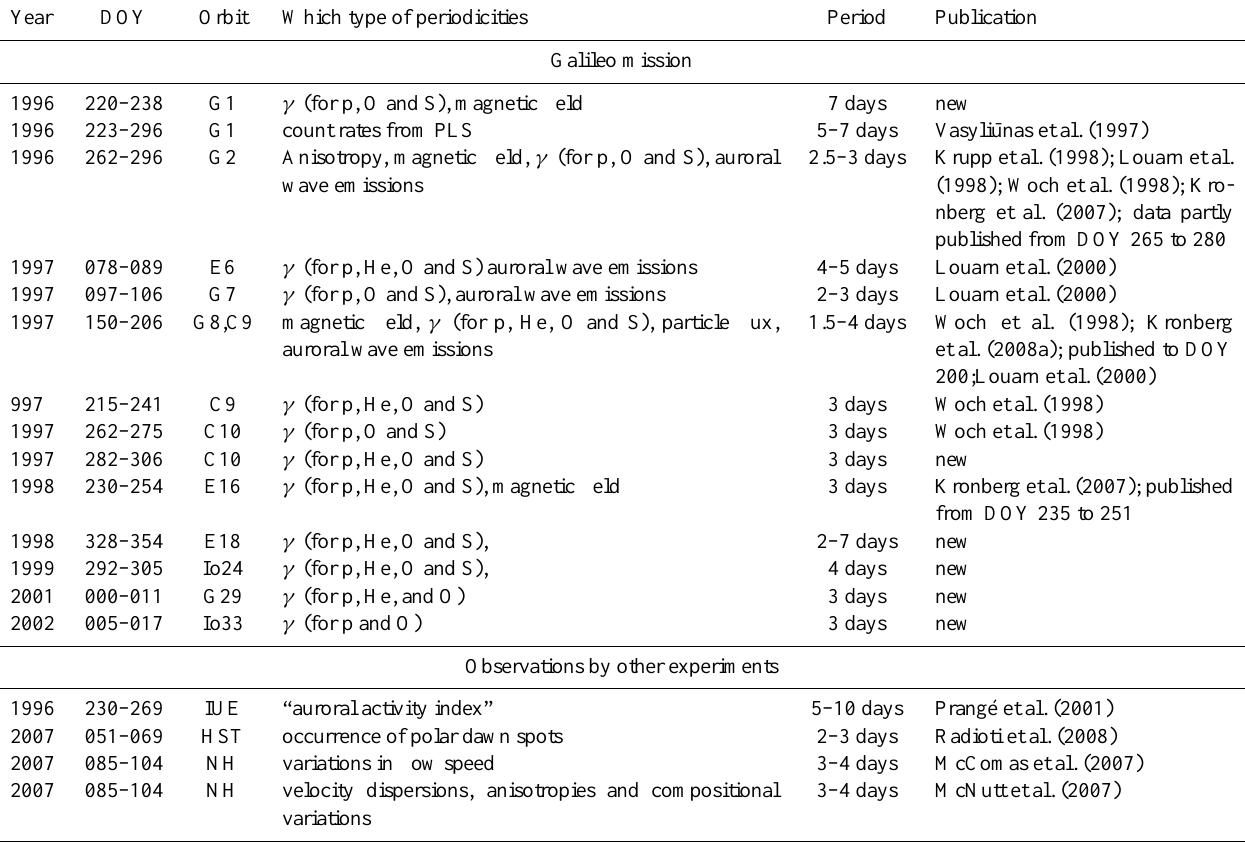
Table 1. Periodicities in the Jovian